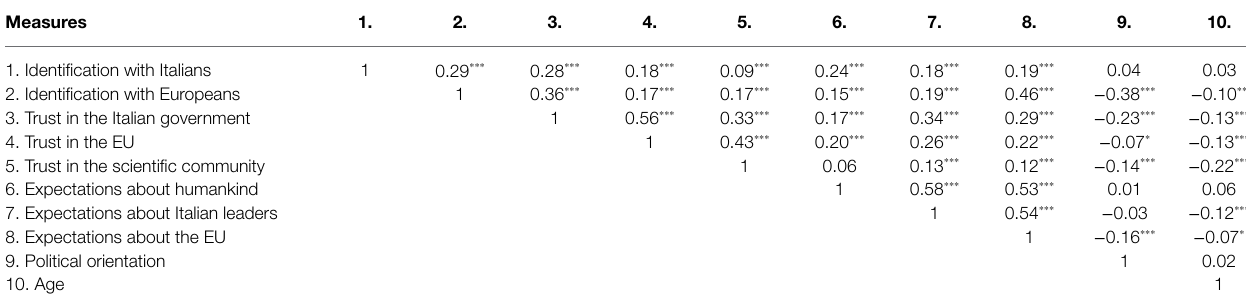
TABLE 2 | Correlations among the study variables.